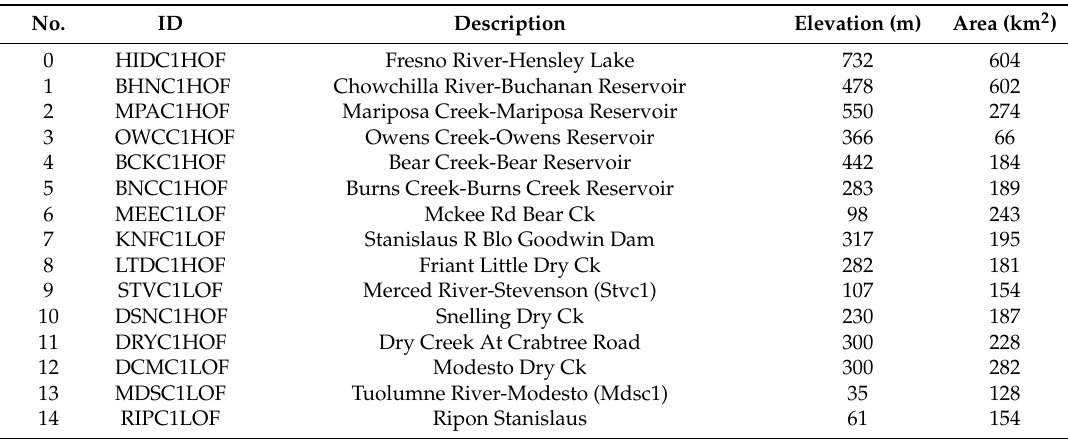
Table A5. Study basins in the San Joaquin